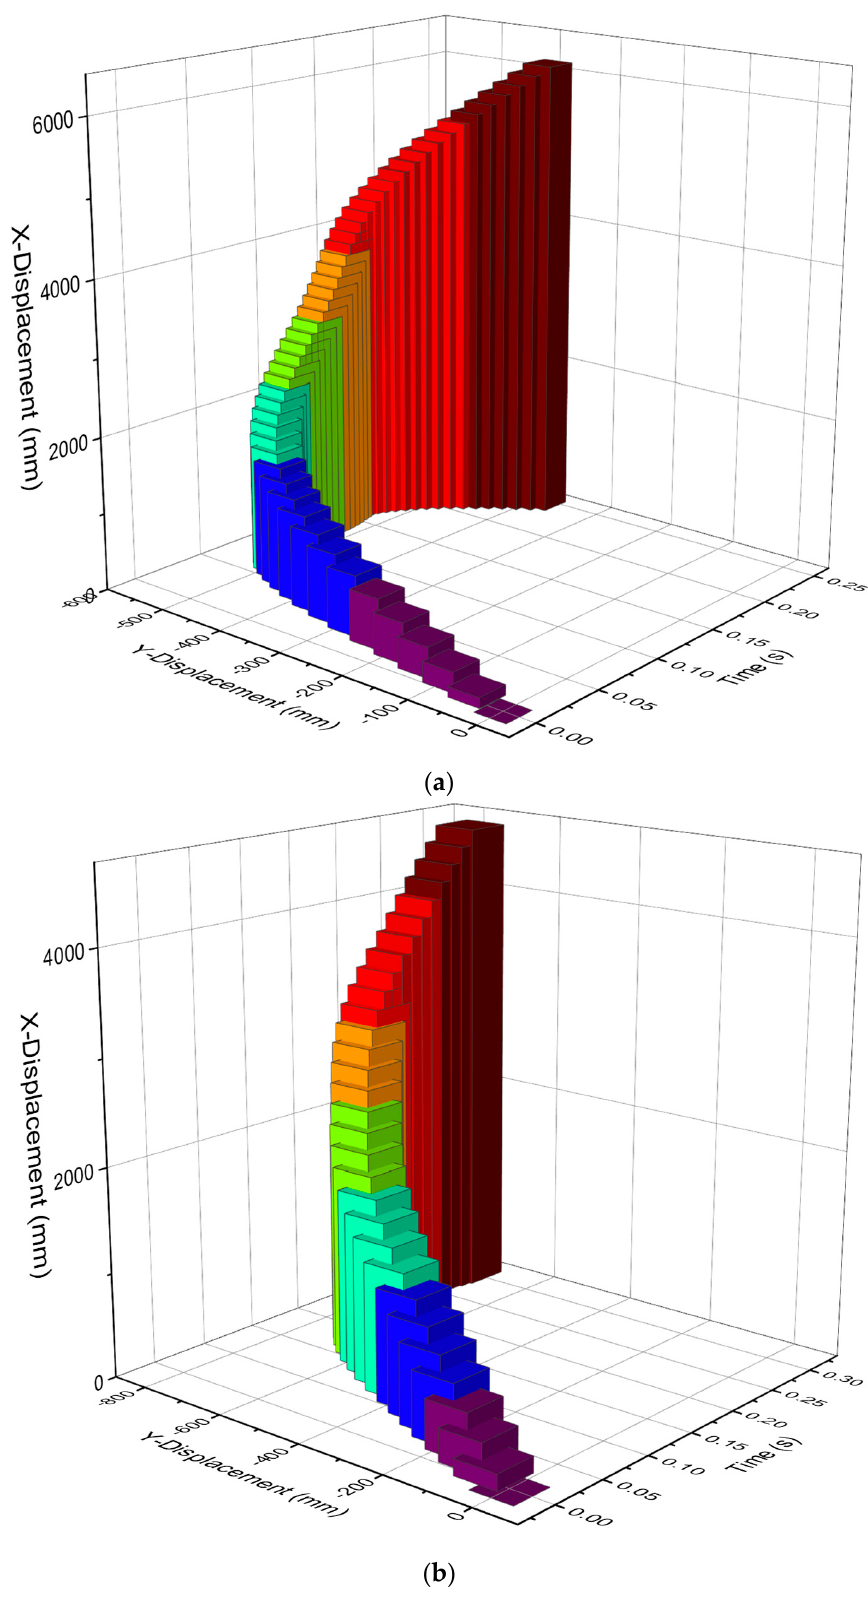
Figure 12. Vehicle trajectory diagram. ( a ) Car trajectory diagram. ( b ) Truck trajectory diagram.